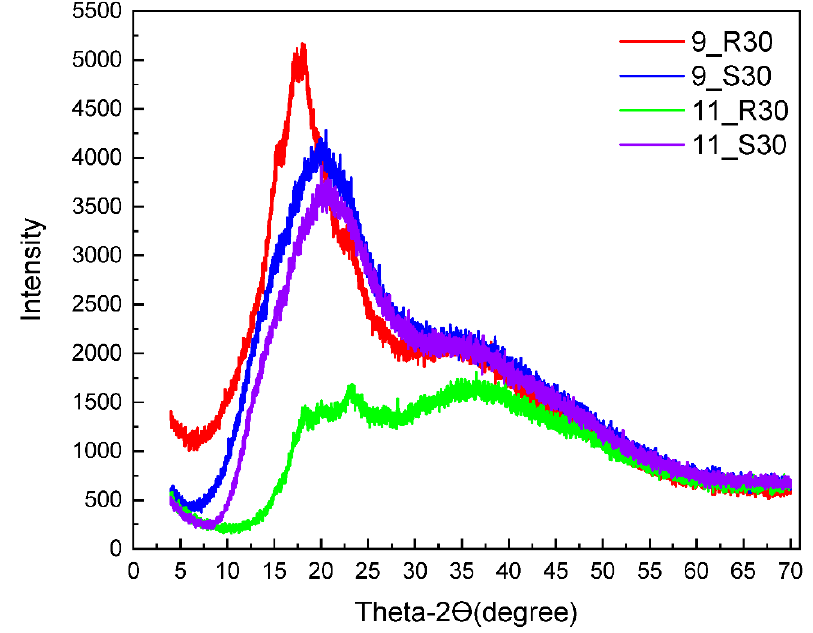
Figure 4. XRD patterns for 9_R30, 9_S30, 11_R30 and 11_S30.